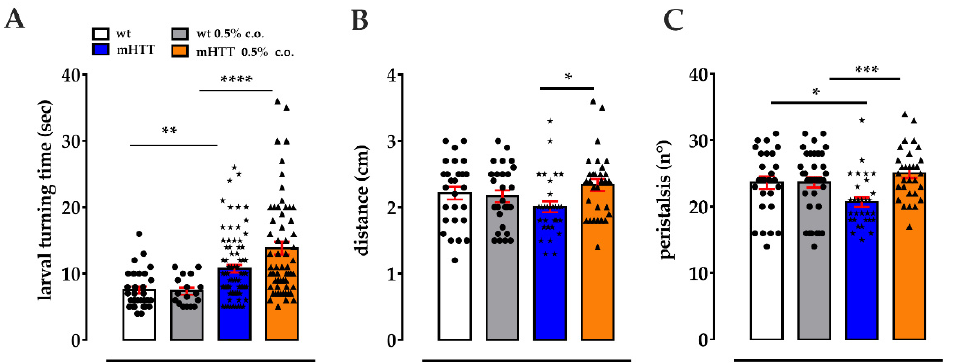
Figure 2. Coconut oil supplementation exacerbates the neurodegenerative phenotype in 3rd instar mHTT larvae. ( A ) Larval turning. mHTT 3rd instar larvae fed on a 0.5% coconut oil supplemented diet (mHTT c.o.) turn to the ventral side significantly more slowly than Q128HD-FL larvae fed on normal food (mHTT), which in turn already turn to the ventral side more slowly than wild-type control. ( B ) Distance. The mHTT larvae fed on food supplemented with 0.5% c.o. travel a significantly greater distance in 30 s than the mHTT larvae fed on normal diet. ( C ) Peristalsis. Number of peristalsis in 30 s during crawling significantly increases in mHTT 0.5% c.o. larvae in comparison to untreated mHTT larvae. In all these assays, no differences were revealed between treated and untreated wt larvae. Values represent mean ± SEM ( n = 3). Sidak’s one-way ANOVA pairwise multiple comparisons test was used to calculate significance. * p < 0.05; ** p < 0.01; *** p < 0.001; **** p < 0.0001. : values of individual wt larvae; ★ , ▲ : values of individual mHTT c.o.-treated and untreated larvae, respectively.